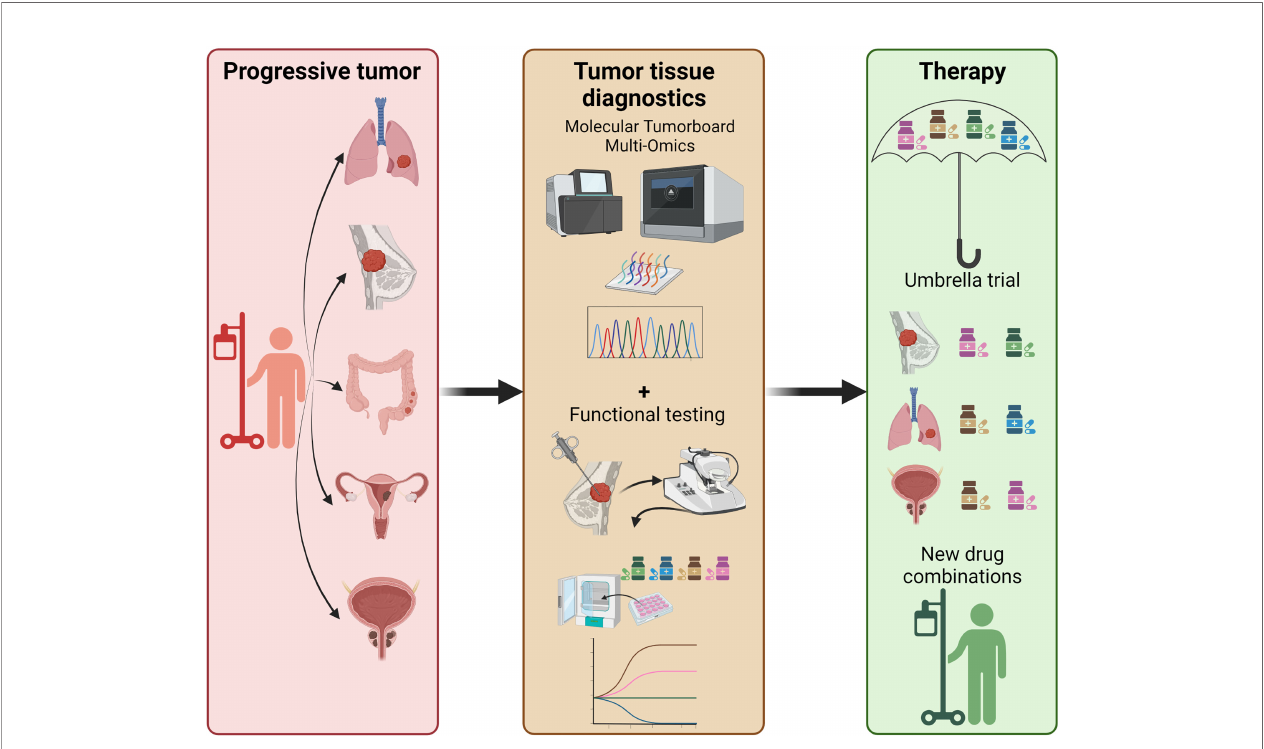
FIGURE 2 | Perspective on future precision oncology platforms integrating molecular + functional data to predictively select the optimal drug combination, i.e. within an umbrella trial. Functional testing includes, but is not limited to, in vitro drug screening on organoids, precision cut tissue slices, tumor fragments; addition of autologous T-cells may also be considered to improve precision medicine approaches in an individual